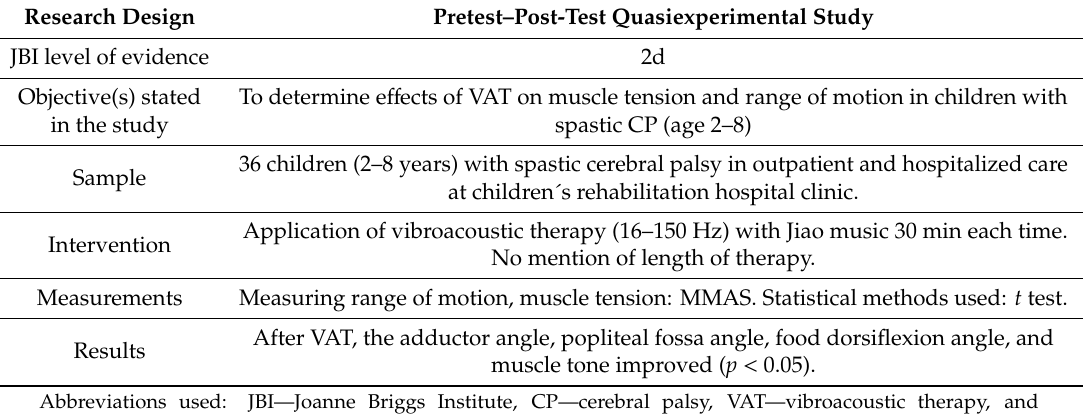
Table 6. Studies on children with CP—Liu et al. [41].